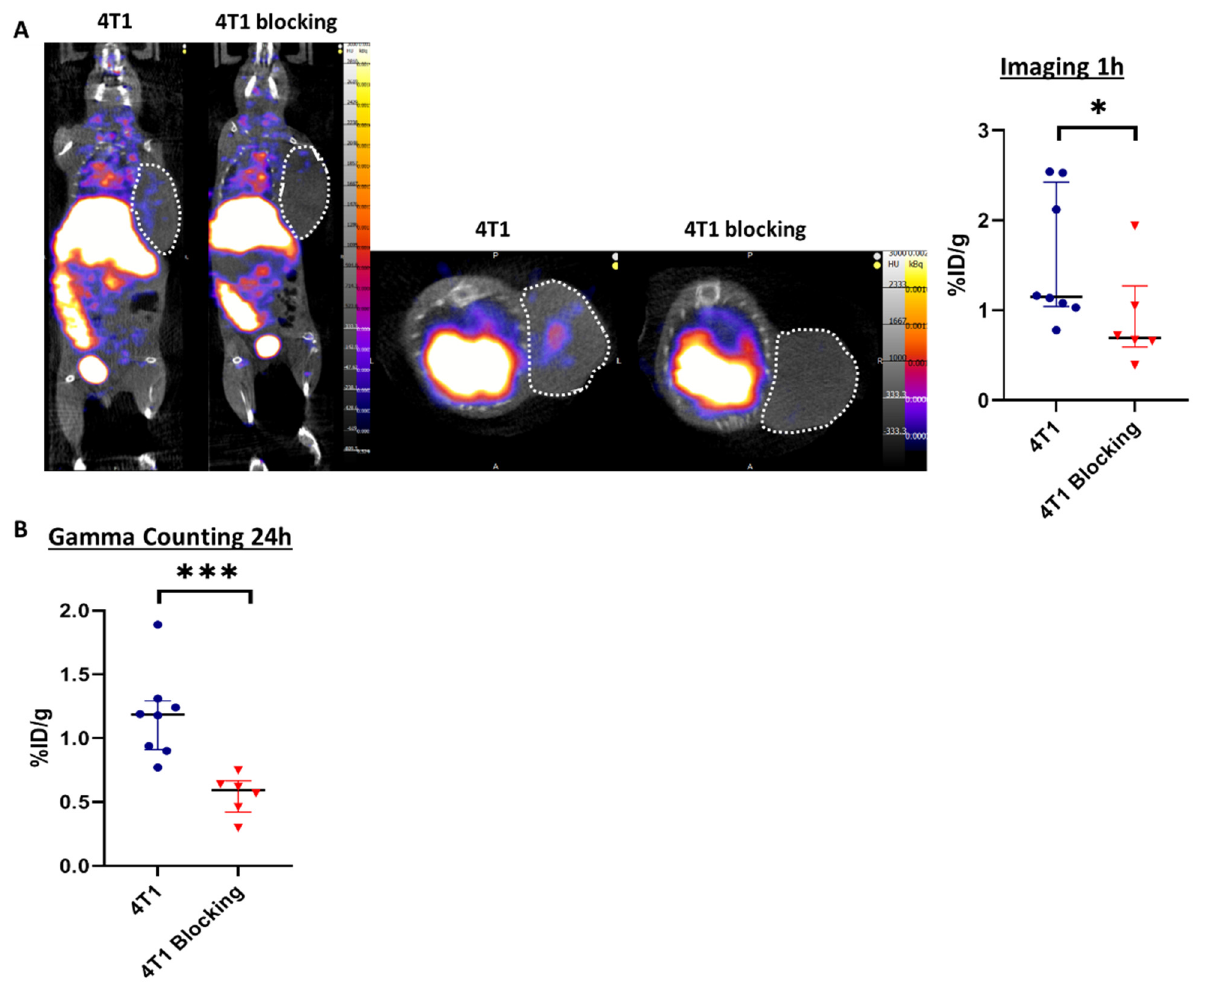
Figure 2. SPECT/CT imaging with 99m Tc-Tilmanocept can specifically detect CD206 + cells in vivo. ( A ) Representative SPECT/CT images of 4T1 tumor-bearing mice at 1 h post-injection of 15 MBq/100 µL of 99m Tc-Tilmanocept (4T1, n = 8) or 15 MBq/100 µL of 99m Tc-Tilmanocept with a 20× excess of cold Tilmanocept (4T1 blocking, n = 6). Results are presented as the median with the interquartile range. The scatter dot plot represents the percentage of the injected dose of 99m Tc-Tilmanocept per gram of tumor (%ID/g) for both groups (* p = 0.0293). ( B ) The scatter dot plot represents the percentage of injected dose of 99m Tc-Tilmanocept per gram of tumor of 4T1 tumor-bearing mice at 24 h post-injection of 15 MBq/100 µL of 99m Tc-Tilmanocept (4T1, n = 8) or 15 MBq/100 µL of 99m Tc-Tilmanocept with a 20x excess of cold Tilmanocept (4T1 blocking, n = 6) measured by gamma counting (*** p = 0.0007).